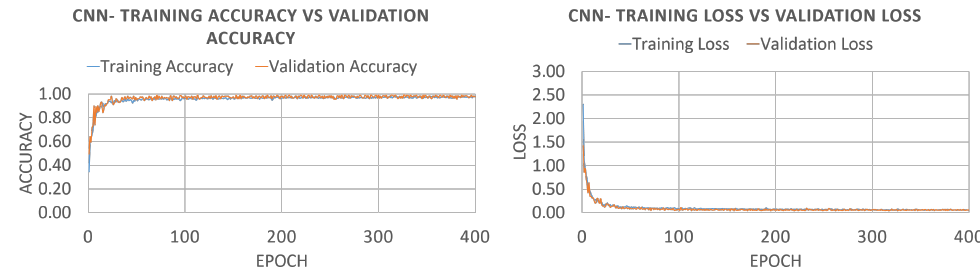
Figure 18. Comparison between the loss and accuracy for the CNN algorithm in both training and validation cycles.